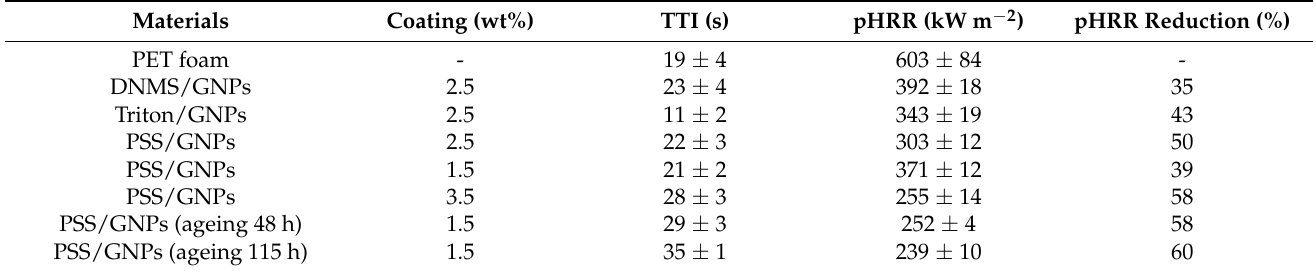
Table 3. Cone calorimeter results for the tested materials at 35 kW m − 2